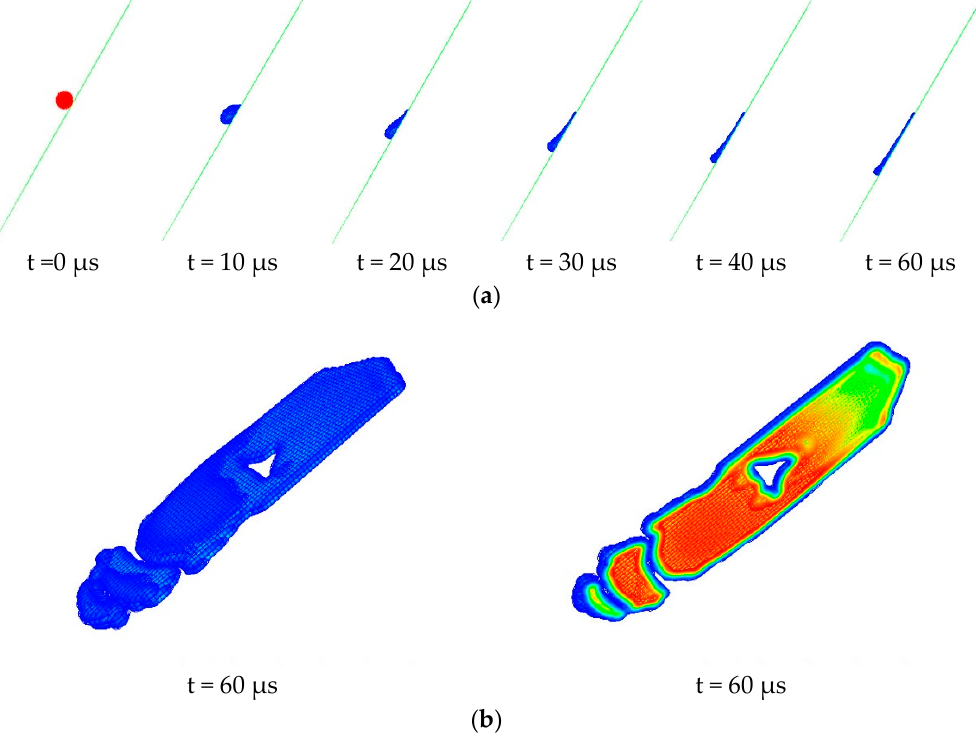
Figure 3. Spreading process of oil droplet (D = 150 μ m, v = 15 m/s, θ = 30°), where the contour plots represent the volume fraction of oil droplet. ( a ) Spreading process of oil droplet in 60 µ s. ( b ) Spreading of oil droplet at 60 µ s.